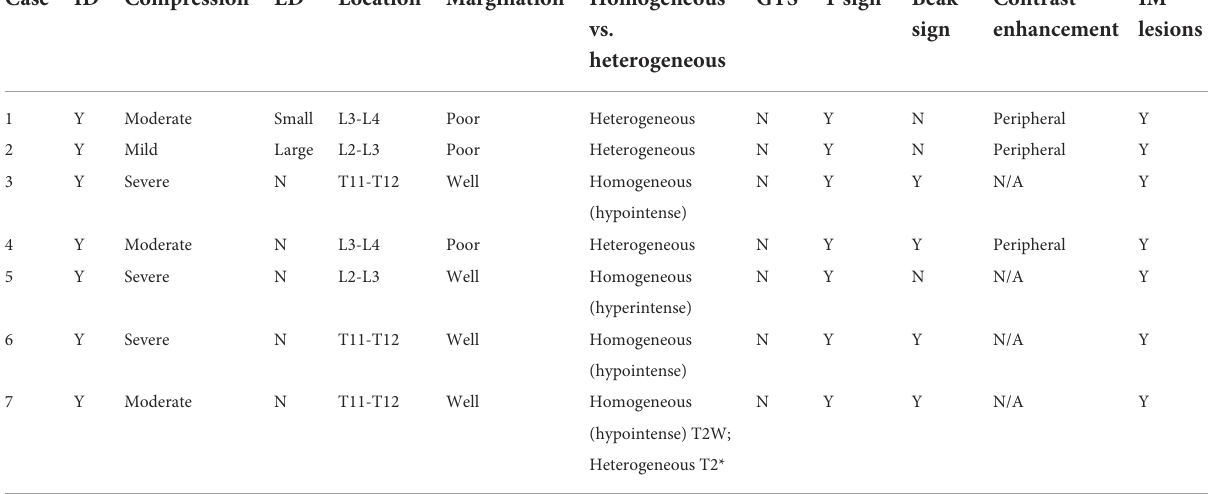
TABLE 2 Summary of MRI